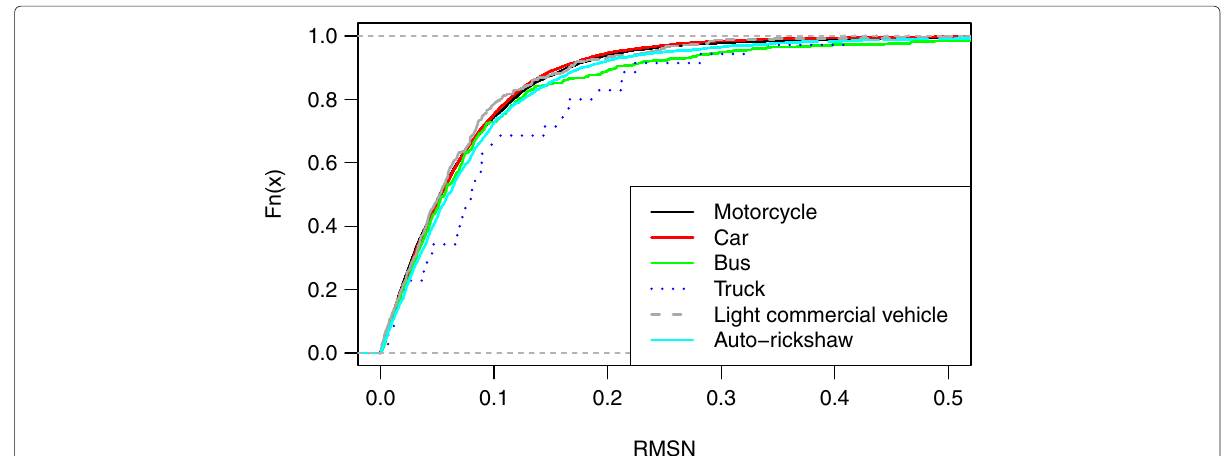
Fig. 8 ECDF of RMSN per vehicle type of the preceding vehicle when the follower is a car (dataset